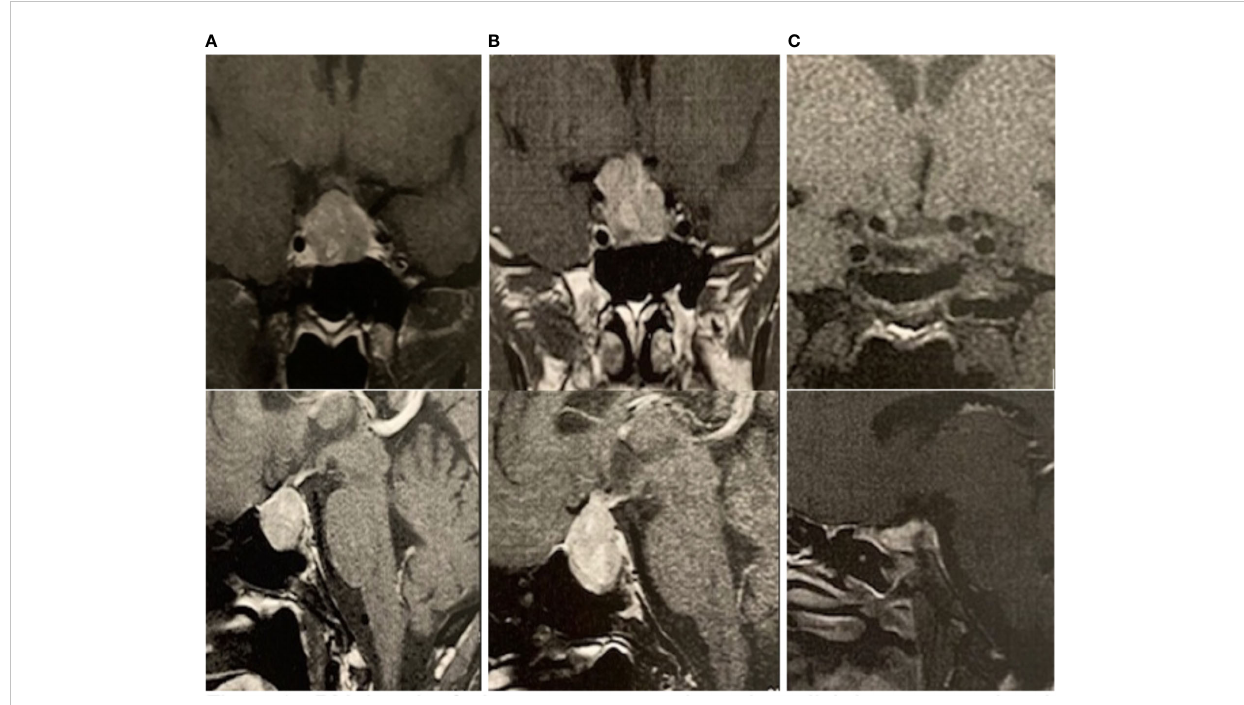
FIGURE 2 Coronal and sagittal MRI of individual II.1 (family 1). T1-weighted image with a 24 × 19 × 18 mm pituitary macroadenoma (A) that evolved after 6 months with hemorrhagic degeneration and compression of the optic chiasm (B) . After surgery, a small remnant can be seen in the left half of the anterior pituitary gland (C)